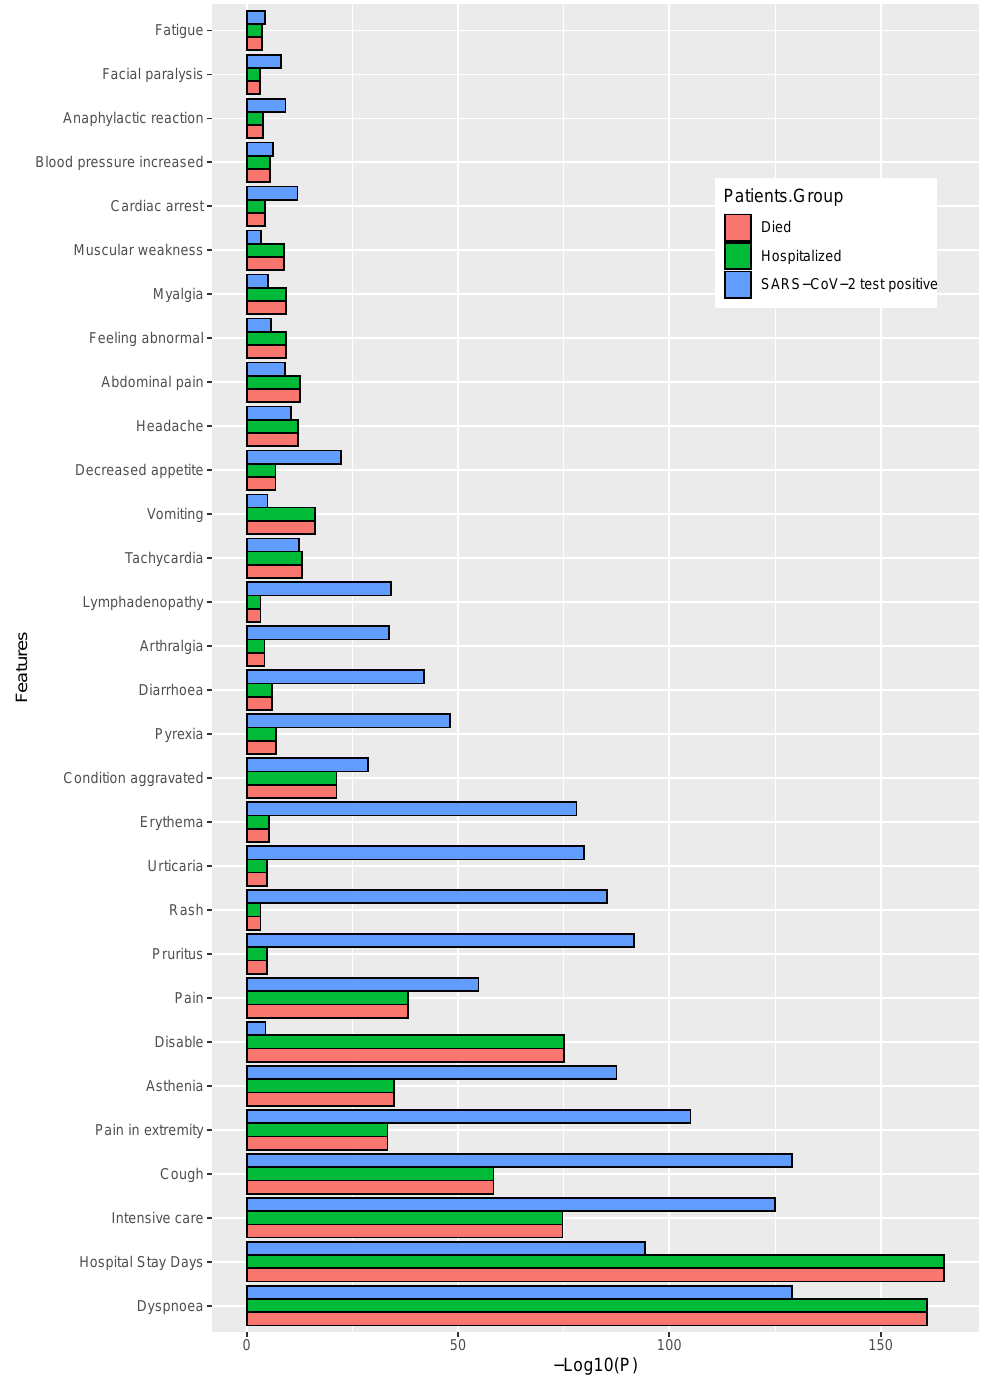
Figure 5. The significant patients’ adverse reactions after vaccination, where the higher bar length indicates greater the